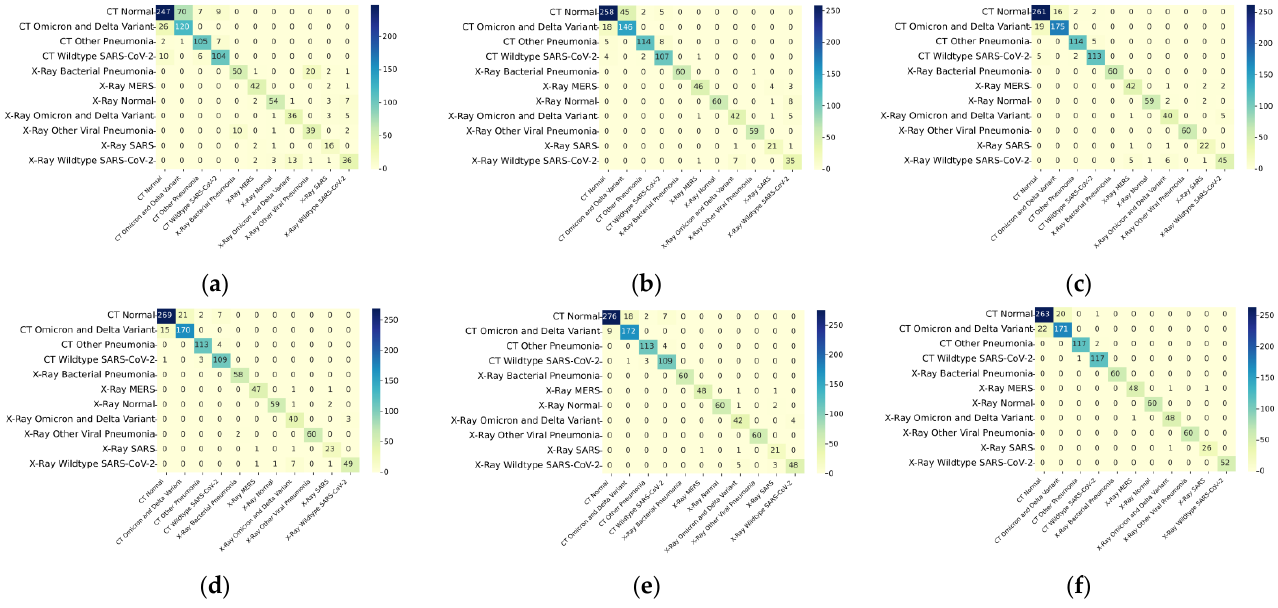
Figure 4. Confusion matrix illustrating the classification results of the models: ( a ) MLP-Mixer B/16; ( b ) Efficientnet-b4; ( c ) ResNet-50; ( d ) ViT-B/16; ( e ) BeiT-v2; ( f ) CoroTrans (ours). Table 3. Results of CoroTrans classification for different